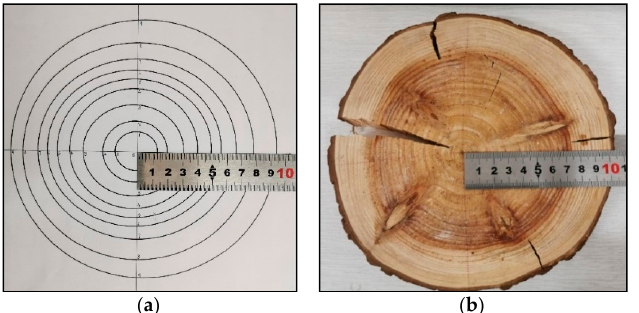
Figure 1. Digital images of stem disk. ( a ) Digital images of self-drawn imitation stem disk; ( b ) digital image of Chinese fir stem disk. Three drawn stem analysis disk samples were measured in four directions to meas- ure the width, and the average values of the measurements in four directions were used to represent the real data set, to verify the research techniques and methods in this paper. The data are shown in Table 1. Table 1. Radius measurement dataset of self-drawn imitation stem disks. SNO is the sample num- ber of the imitation stem disk. RNO is the number of the growth ring (the number starts at the heart of the pith). D1, D2, D3, and D4 represent four measurement directions. RV is the value of the radius of the ring. MV is the mean of the ring radius in the four directions.